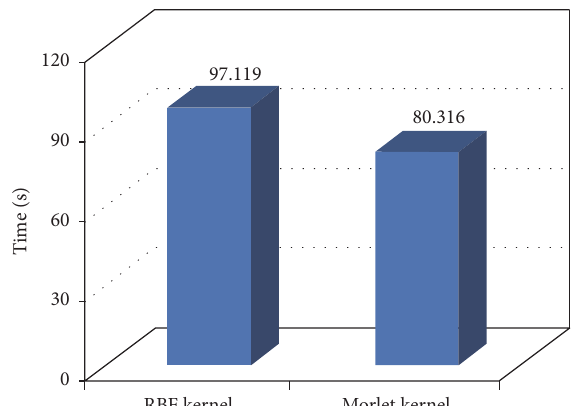
Figure 9: The consuming time of RBF kernel and Morlet kernel, respectively.